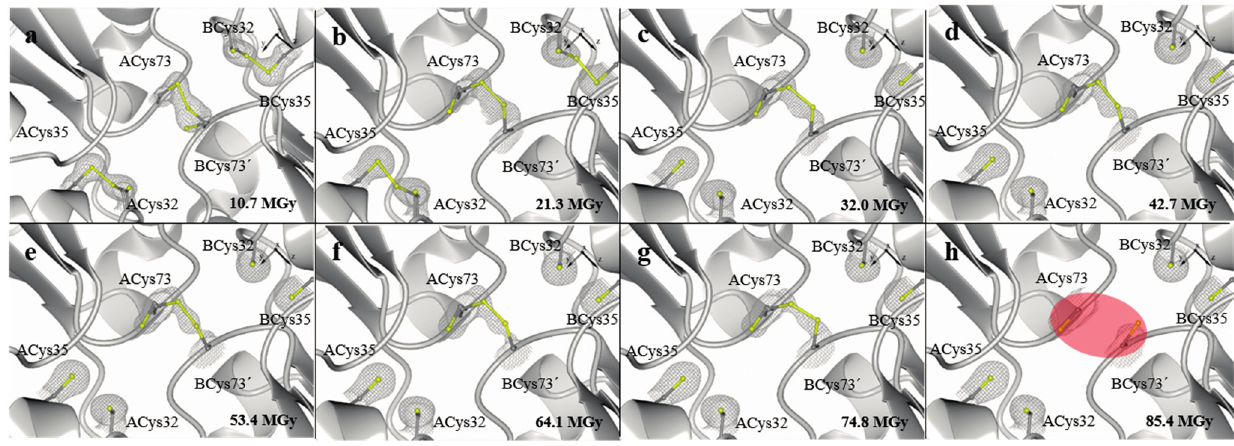
Figure 3. Crystal structures of Lv Trx-3x showing the deterioration of the catalytic disulfide bond (ACys32-ACys35and BCys32-BCys35) and the interface disulfide bond (Cys73-Cys73') caused by radiation damage. The energy with which each dataset was obtained of the crystal Lv Trx-3x was three-times higher (27% transmission, 4.14 × 10 11 photons s − 1 ) than the crystal Lv Trx-1x. ( a ) First dataset collected at 10.7 MGy; ( b ) second dataset collected at 21.3 MGy; ( c ) third dataset collected at 32 MGy, a dose at which the catalytic disulfide bond is completely reduced, similar to what was obtained in the crystal Lv Trx-1x; ( d ) fourth dataset collected at 42.7 MGy; ( e ) fifth dataset collected at 53.4 MGy; ( f ) Sixth dataset collected at 64.1 MGy; ( g ) seventh dataset collected at 74.8 MGy; ( h ) eighth dataset collected at 85.4 MGy, showing that at this dose, the interface disulfide bond is completely broken (highlighted in red oval). Datasets 9 and 10 are not shown, because the expected result was obtained in Dataset 8. Electron-density maps 2Fo-Fc are shown in gray and contoured at 1.0 σ . The figures were generated with CCP4mg, and the video can be viewed in the Supplementary